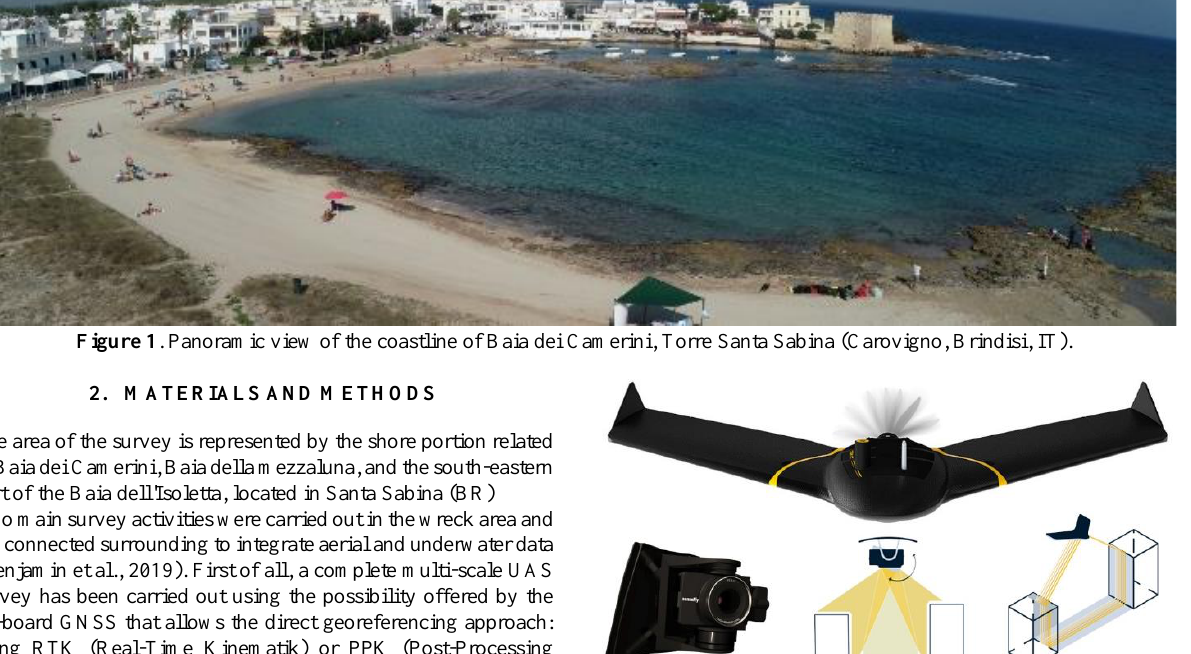
Figure 2. The eBee X fixed-wing platform with the SODA 3D camera and the scheme of the camera tilting option.